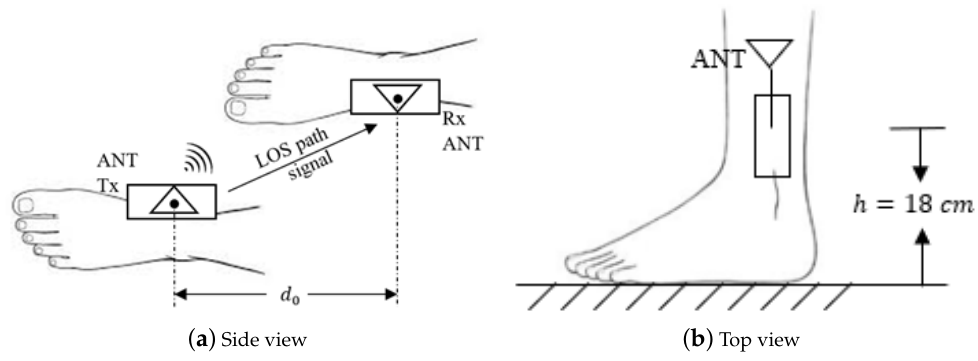
Figure 2. Schematic diagrams of the on-ankle transceivers.